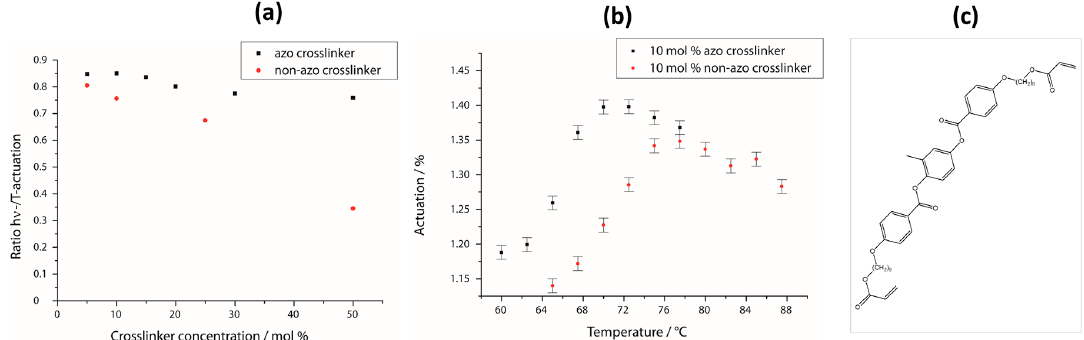
Figure 8. Comparison of the azo crosslinker with a similar non-azo crosslinker. ( a ) Ratio between photo- and thermal-actuation as a function of the crosslinker concentration, respectively; ( b ) comparison of the temperature dependence of both systems’ photoactuation; ( c ) chemical structure of the non-azo crosslinker.